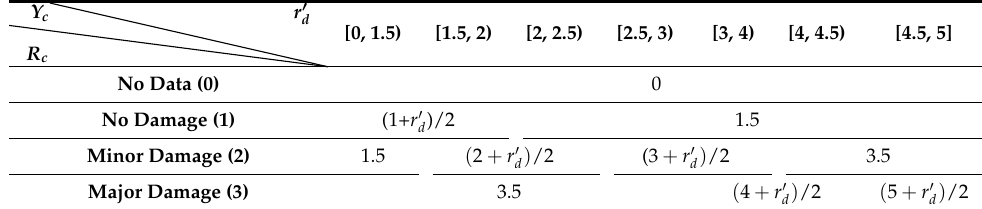
Table 3. Lookup table to determine Y c .